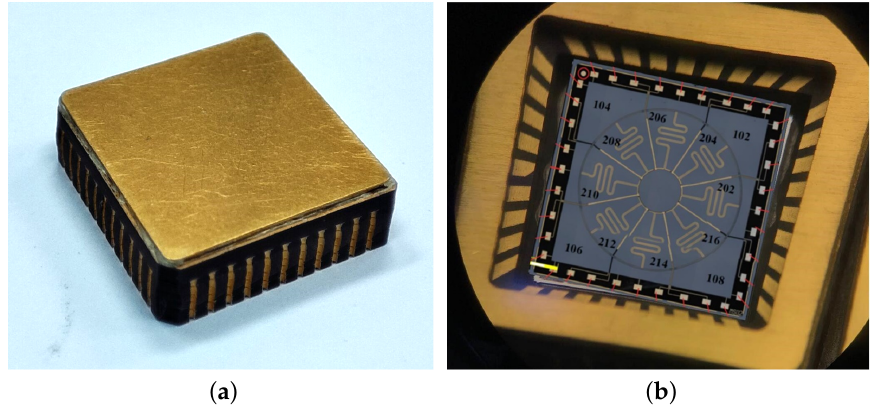
Figure 7. The sample annular MEMS gyro used in experiments. ( a ) The external package of sample gyroscope. ( b ) The internal structure of the sample